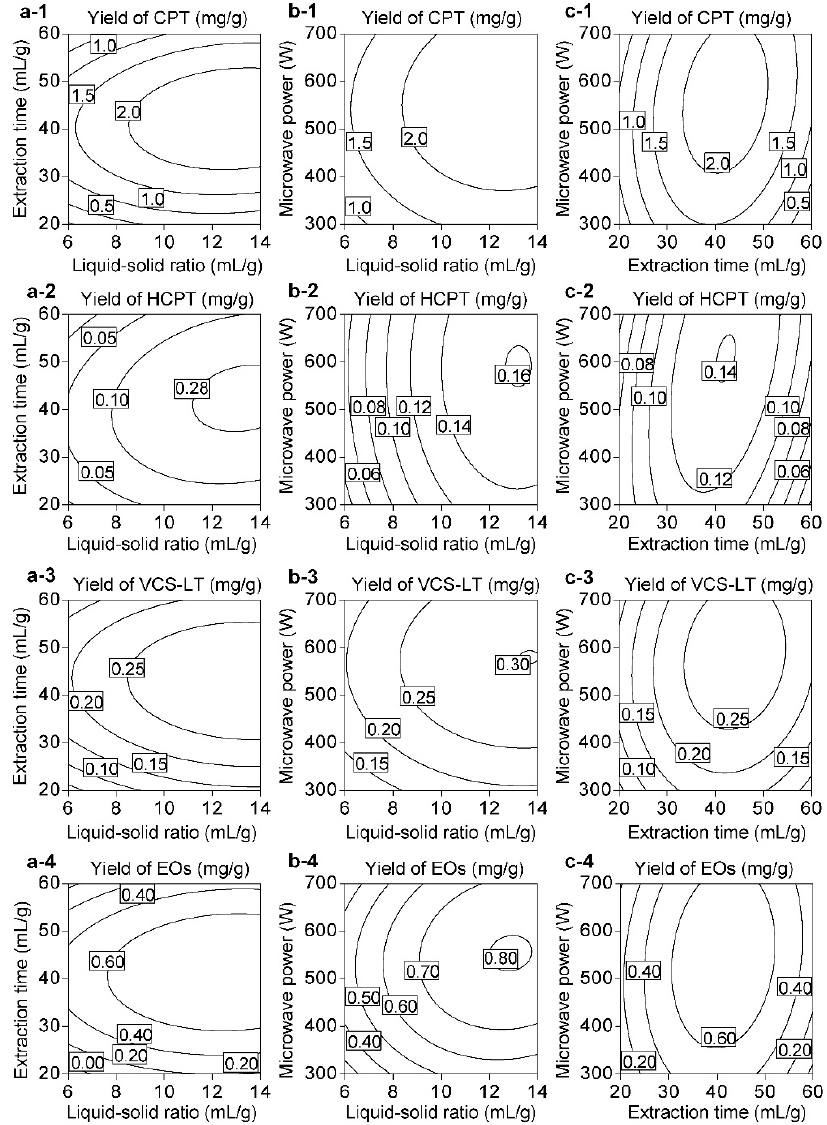
Figure 6. Contour plots for extraction of CPT, HCPT, VCS ‐ LT, and EOs using IL ‐ UMASDE method: effect of liquid–solid ratio and extraction time on yields of CPT ( a ‐ 1 ); HCPT ( a ‐ 2 ); VCS ‐ LT ( a ‐ 3 ); and EOs ( a ‐ 4 ); effect of liquid–solid ratio and microwave power on yields of CPT ( b ‐ 1 ); HCPT ( b ‐ 2 ); VCS ‐ LT ( b ‐ 3 ); and EOs ( b ‐ 4 ); and effect of extraction time and microwave power on yields of CPT ( c ‐ 1 ); HCPT ( c ‐ 2 ); VCS ‐ LT ( c ‐ 3 ); and EOs ( c ‐ 4 ).